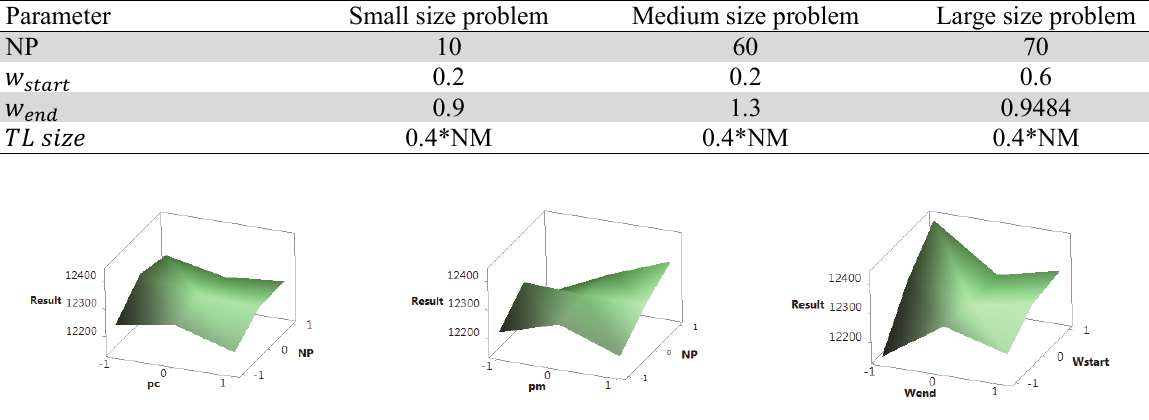
Fig. 1. 3D surface plot involving NP and p c for PSO-GA